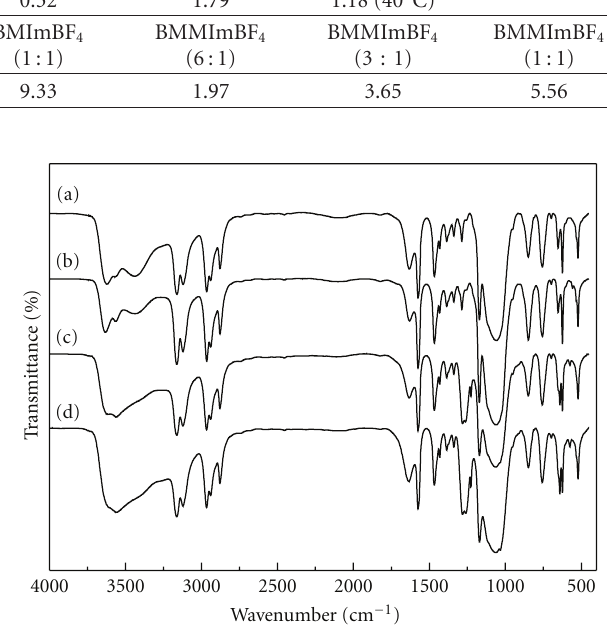
Figure 2: FTIR spectra of (a) BMImBF 4 , (b) BMImBF 4 + THF (3:1), (c) 0.3 molL − 1 BMImBF 4 /Mg(CF 3 SO 3 ) 2 , and (d)